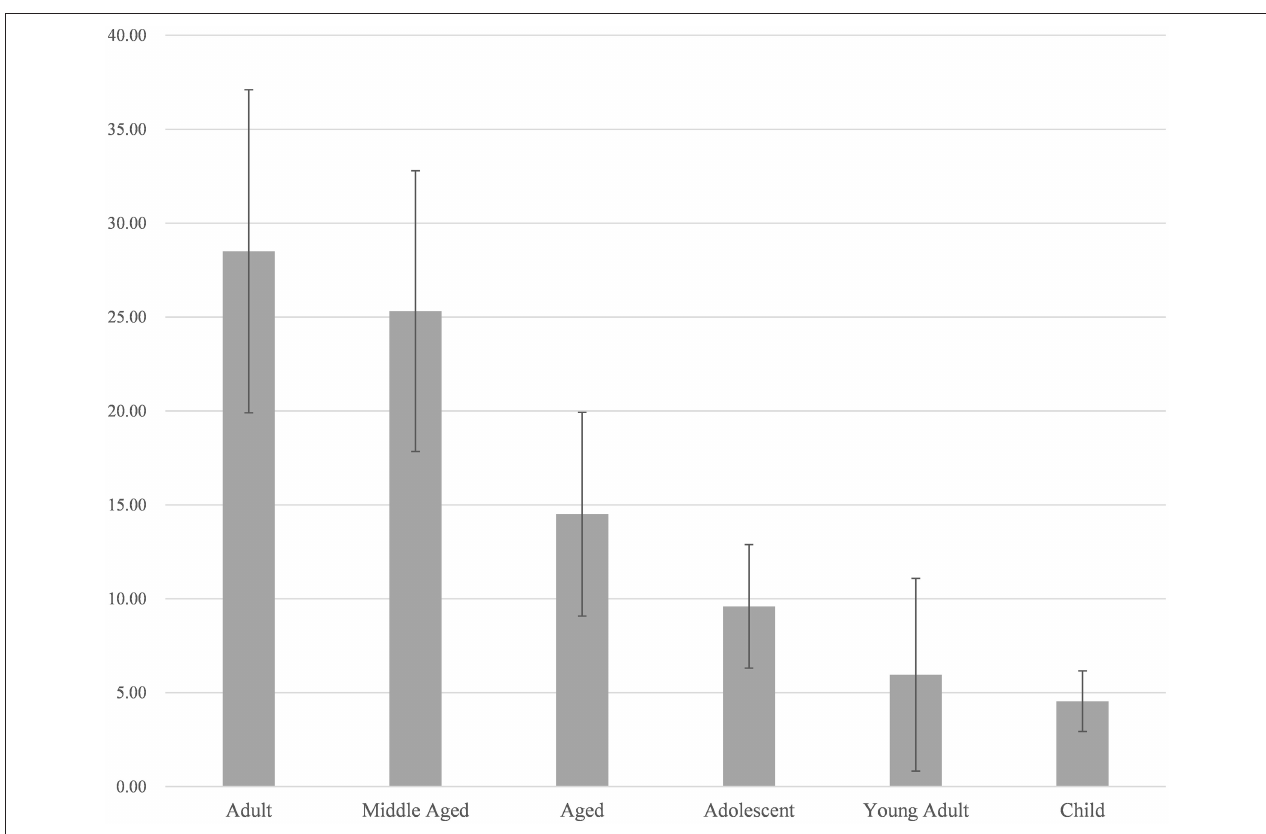
FIGURE 2 | Annual output of literature, broken down by age group.